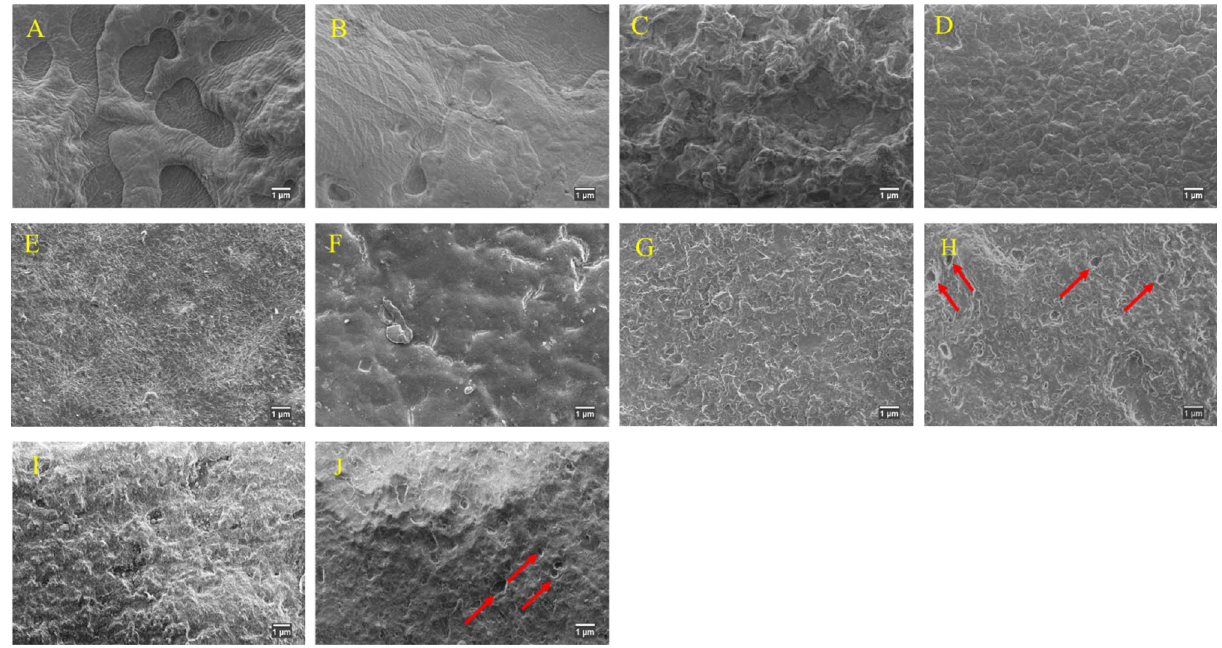
Figure 2. FESEM micrographs of different glove variants before and after exposure to the pesticide at 37 °C; Nitrile 1 ( A ) before, ( B ) after; NR Latex 1 ( C ) before, ( D ) after; SH glove ( E ) before, ( F ) after; Nitrile 2 ( G ) before, ( H ) after; NR Latex 2 ( I ) before, ( J ) after permeation